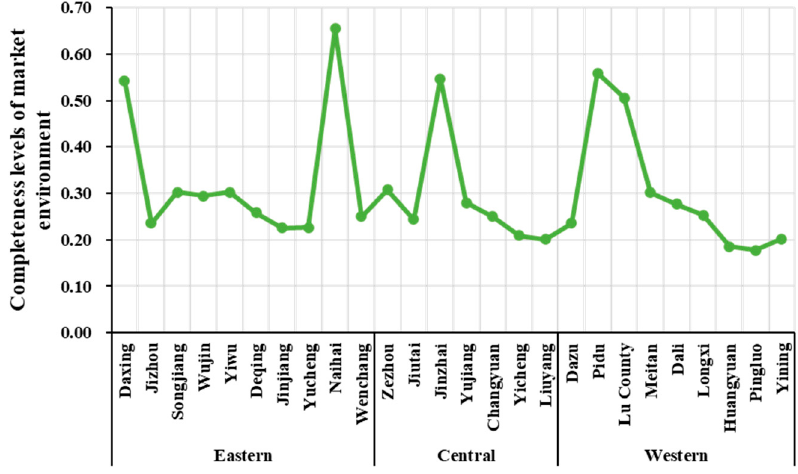
Figure 9. Completeness level of CCCL transaction environment in 26 pilot areas.